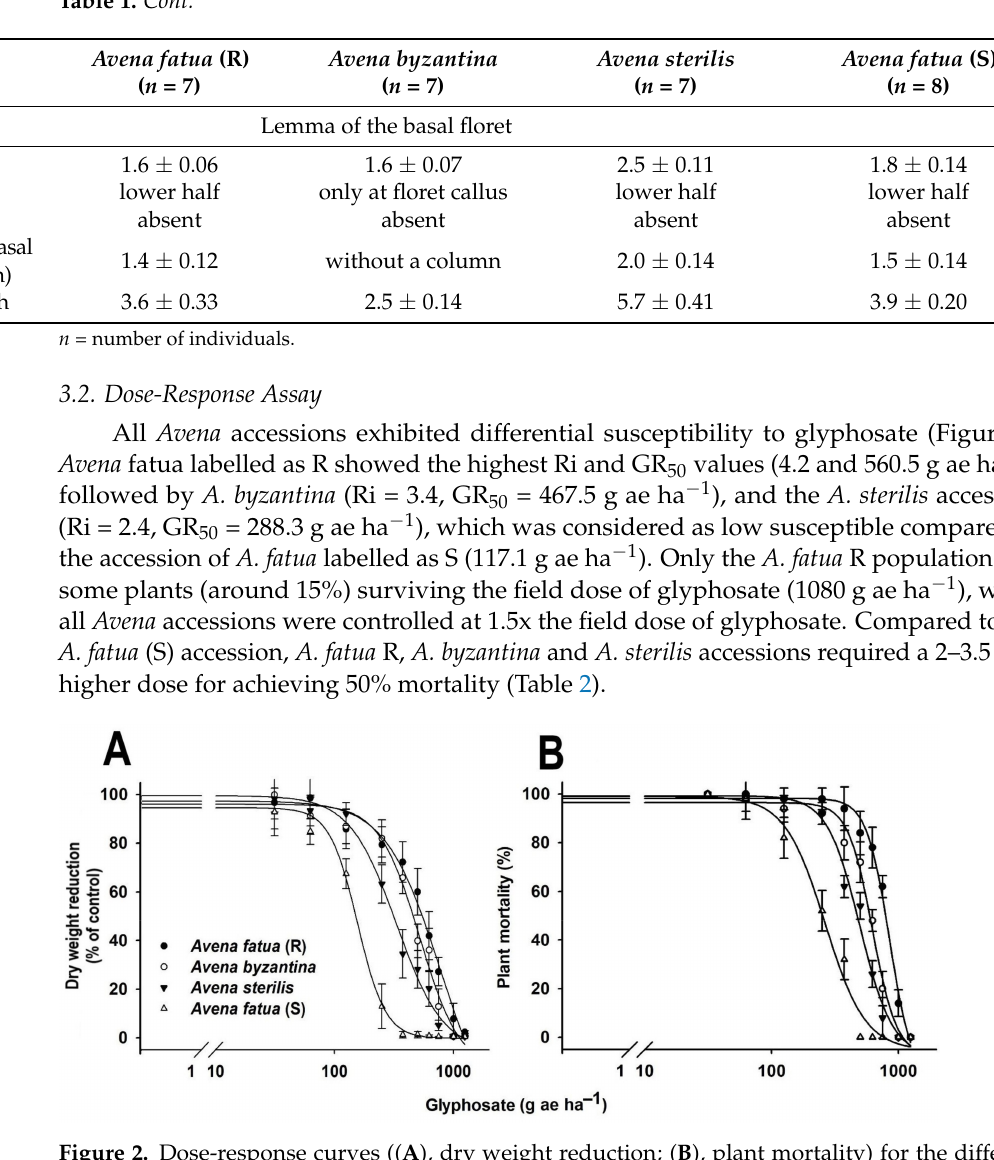
Figure 2. Dose-response curves (( A ), dry weight reduction; ( B ), plant mortality) for the different Avena accessions. Vertical bars represent the standard error of the means ( n = 20). Table 2. Parameters of the log-logistic regression to estimate the mean dose (g ae ha − 1 ) of